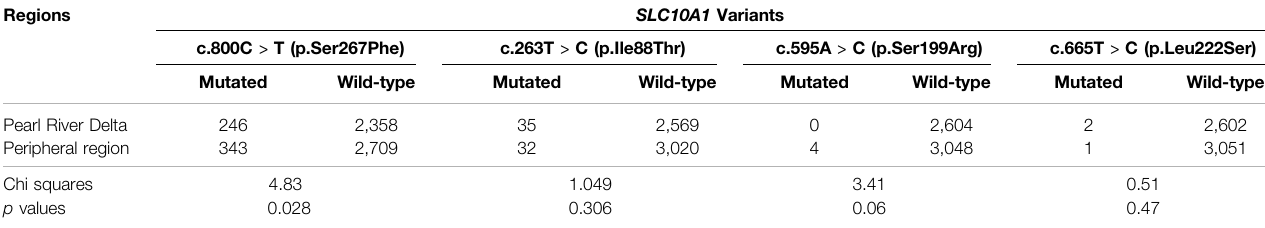
TABLE 3 | Comparison of the distribution of the four prevalent SLC10A1 variants between the Pearl River Delta and the peripheral region. Regions